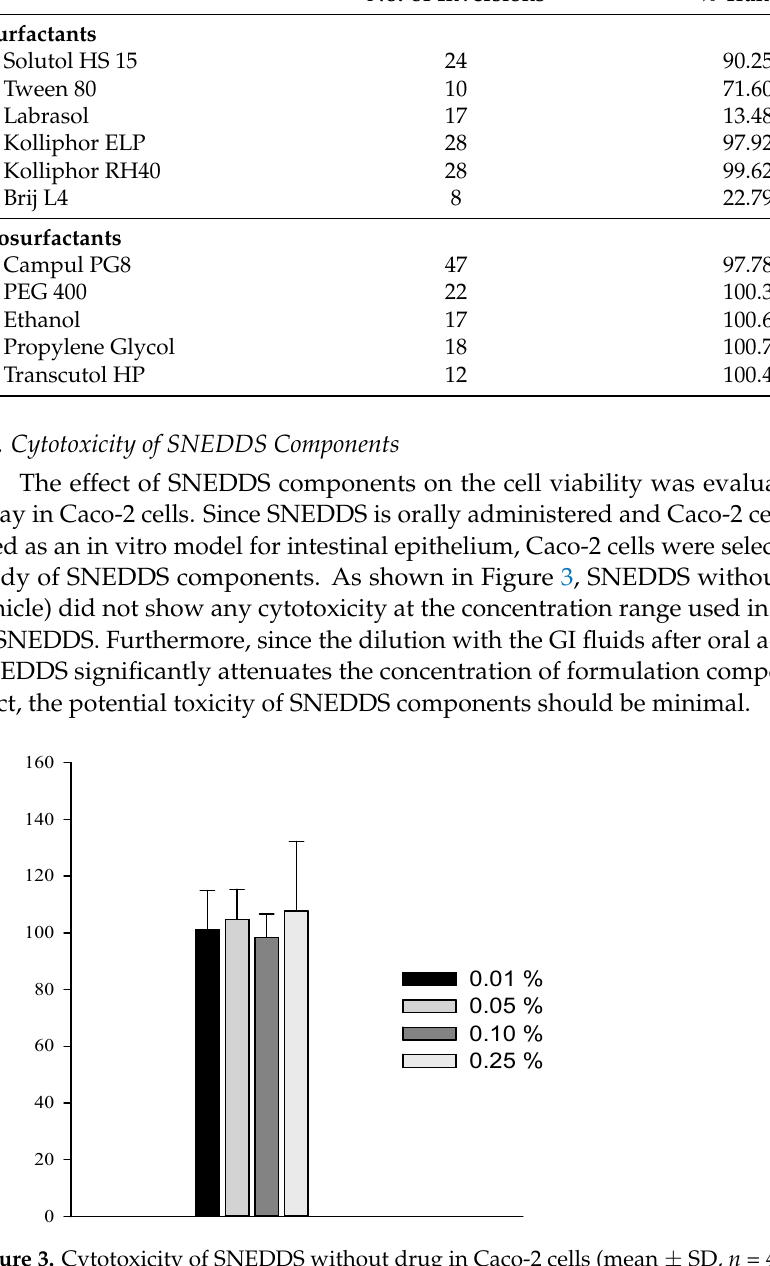
Table 1. Emulsification efficiency of various surfactants and cosurfactants (mean ± SD, n = 3).